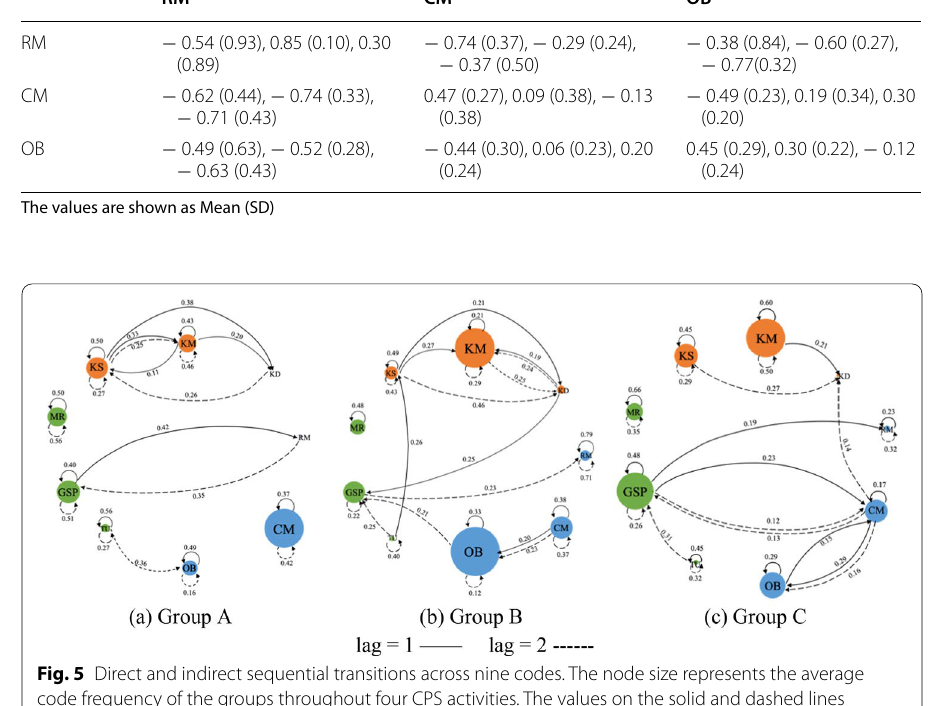
Table 7 Direct transitional patterns of the behavioral dimension (Group A, Group B, Group C) Current move Upcoming move